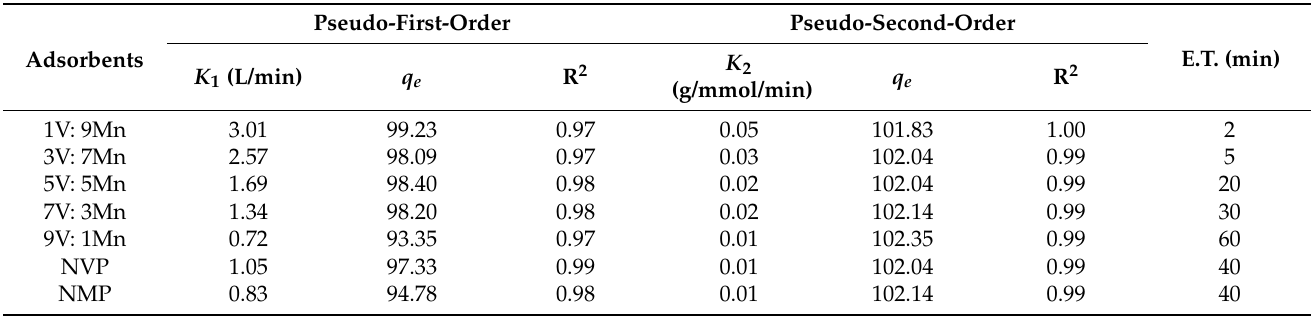
Figure 3. ( a ) NVP@NMP adsorption kinetic curves, ( b ) 1V: 9Mn adsorption kinetic curve (second- order adsorption kinetic fitting curves, EC = Equilibrium concentration), ( c ) Pseudo-first-order model, pseudo-second-order model and intraparticle diffusion models. Table 1. Different NVP@NMP of the adsorption kinetic model fitting of Sr 2+